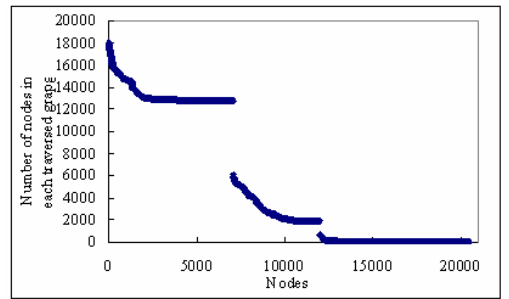
Fig. 4. Cluster of nodes in citation network